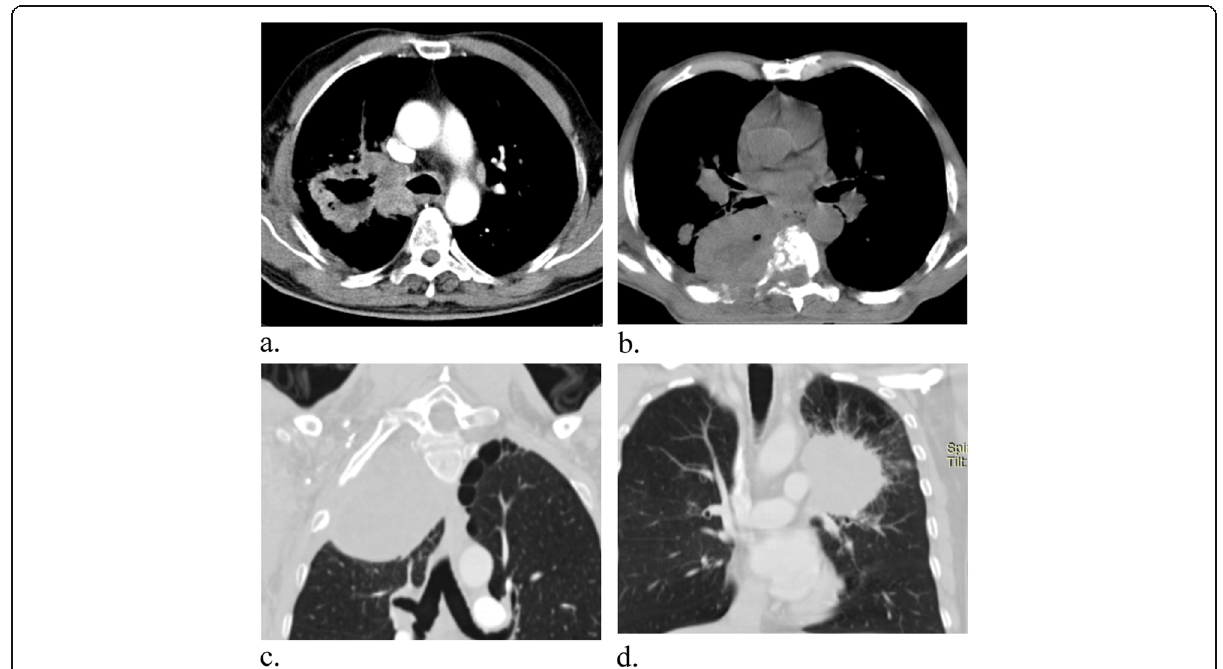
Fig. 1 Four different cases of squamous cell carcinoma. a shows the classical CT appearance with thick walled central hilar cavitary lesion. b shows a peripheral thick cavitary lesion with invasion of the pleura, chest wall, and the posterior mediastinum. c shows a superior sulcus tumor with invasion of the chest wall (not shown) and d shows a speculated lung parenchymal mass lesion separable from the hilum (not shown) invading the mediastinum